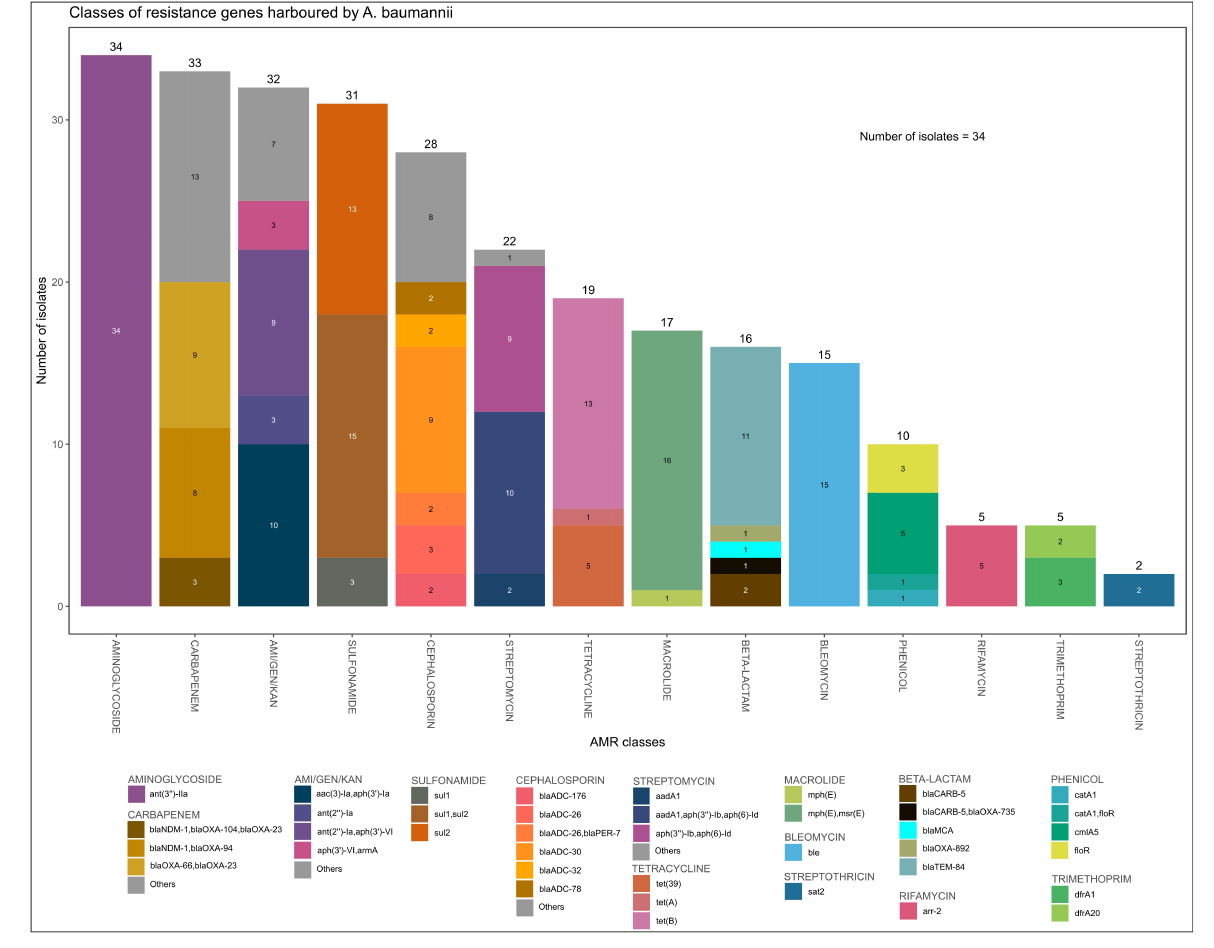
FIGURE 3 | Resistance genes detected in A. baumannii isolates from OAUTCH, Ife, Osun State, and UCH, Ibadan, Oyo State, Nigeria, between 2017 and 2019. AMI, Amikacin; GEN, Gentamicin; KAN,